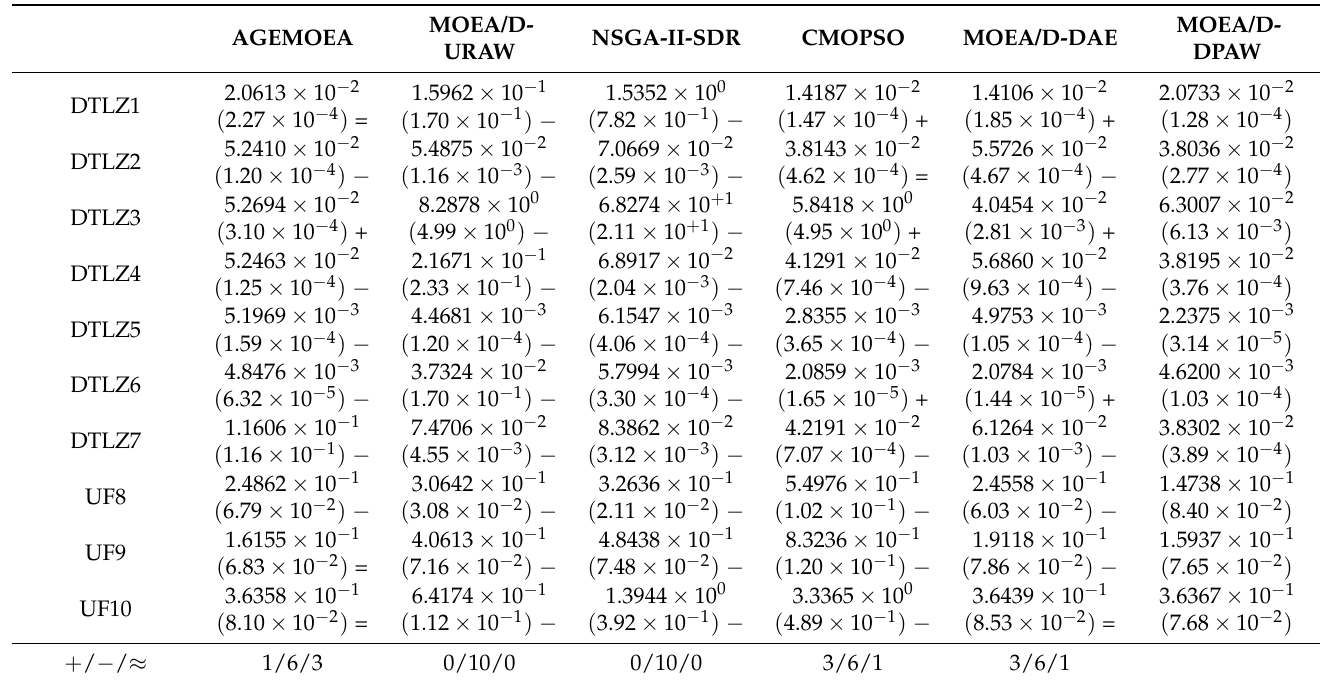
Table 3. IGD values obtained by six algorithms about three-objective optimization problems on DTLZ and